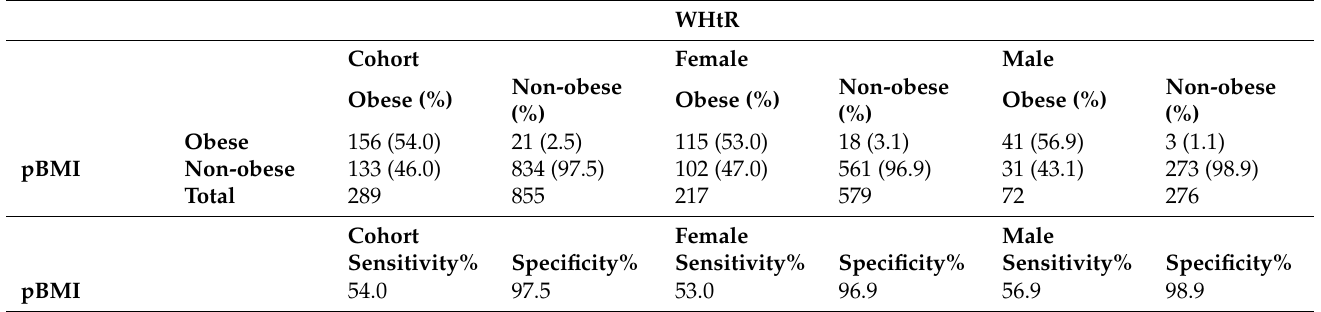
Table 4. Sensitivity and specificity of BMI percentile in screening obesity using WHtR as reference.